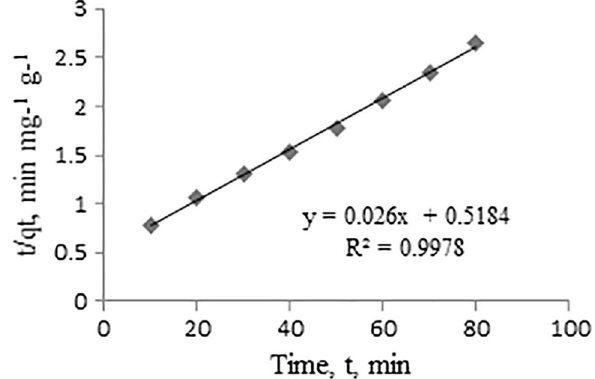
Fig. 7 Plots of pseudo-second order